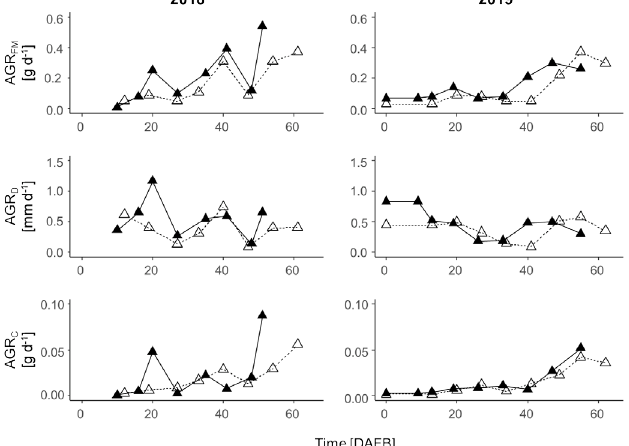
Fig. 2: Time course of absolute growth rates in fresh mass (AGR FM ), dia- meter (AGR D ), and elemental carbon (AGR C ) of developing 'Bellise' (closed symbol, solid line) and 'Regina' (open symbol, dotted line) sweet cherry fruit in two years.